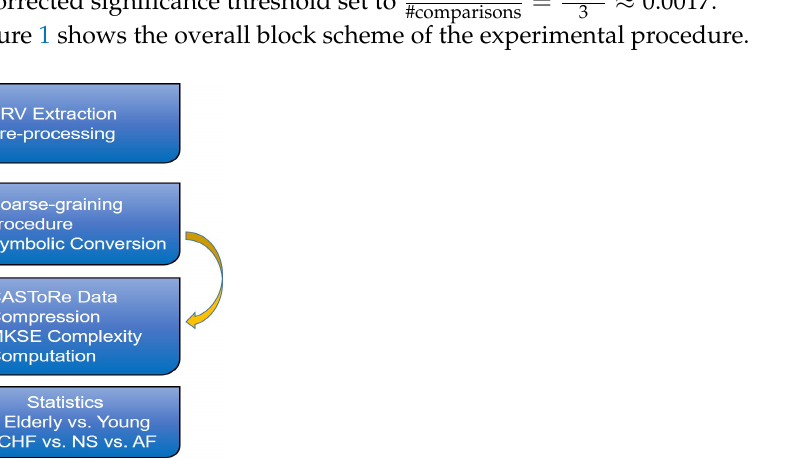
Figure 1. Block scheme of the experimental procedure. HRV series are derived from ECG series and are eventually preprocessed to correct artifacts. Then, artifact-free series are coarse-grained according to a multiscale approach and converted into symbolic series. The lossless data compression CASToRe is then applied to compute K-S entropy at each partition and scaling time, for which group-wise inferential statistics are finally performed to evaluate the elderly vs. young and CHF vs. NS vs. AF